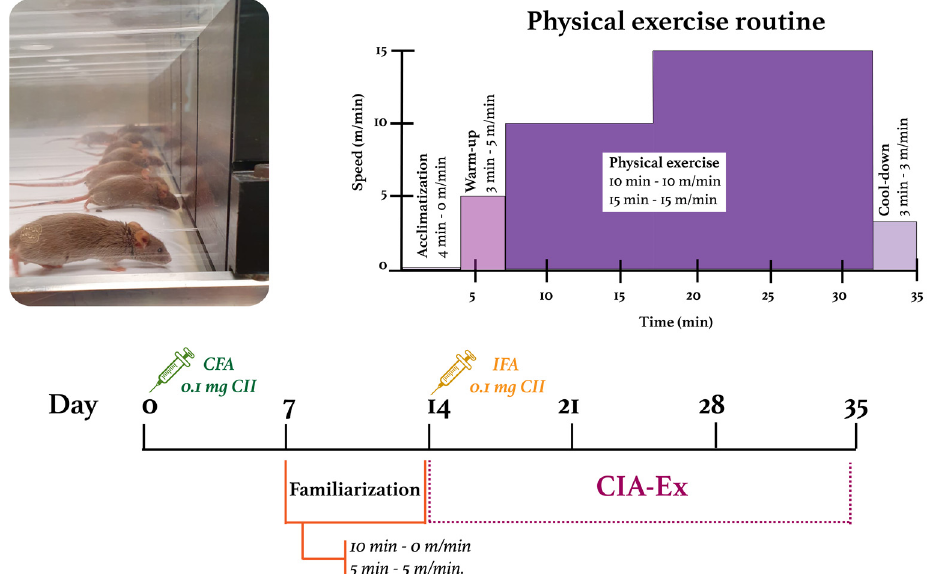
Figure 1. Experimental design and characteristics of the treadmill physical exercise routine. CFA: